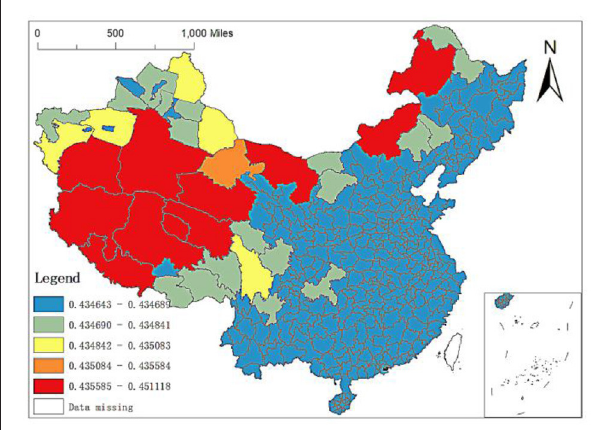
FIGURE 10 | Spatial distribution of regression coefficients of medical colleges in MGWR-SAR